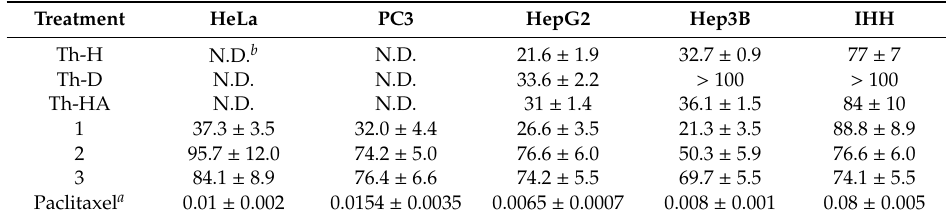
Table 2. Maximal inhibitory concentration IC 50 values of extracts ( µ g / mL) and Compounds 1 – 3 ( µ M) against various cancer cell lines and one non-cancerous